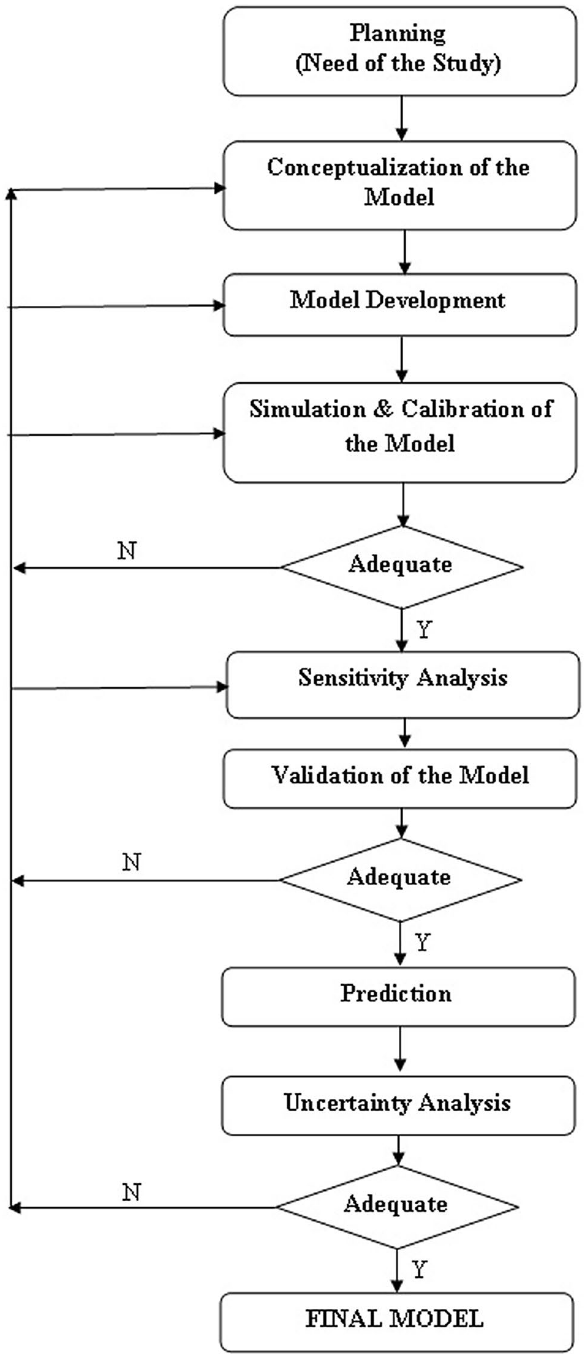
Fig. 1 Flowchart of methodology for preparation of the